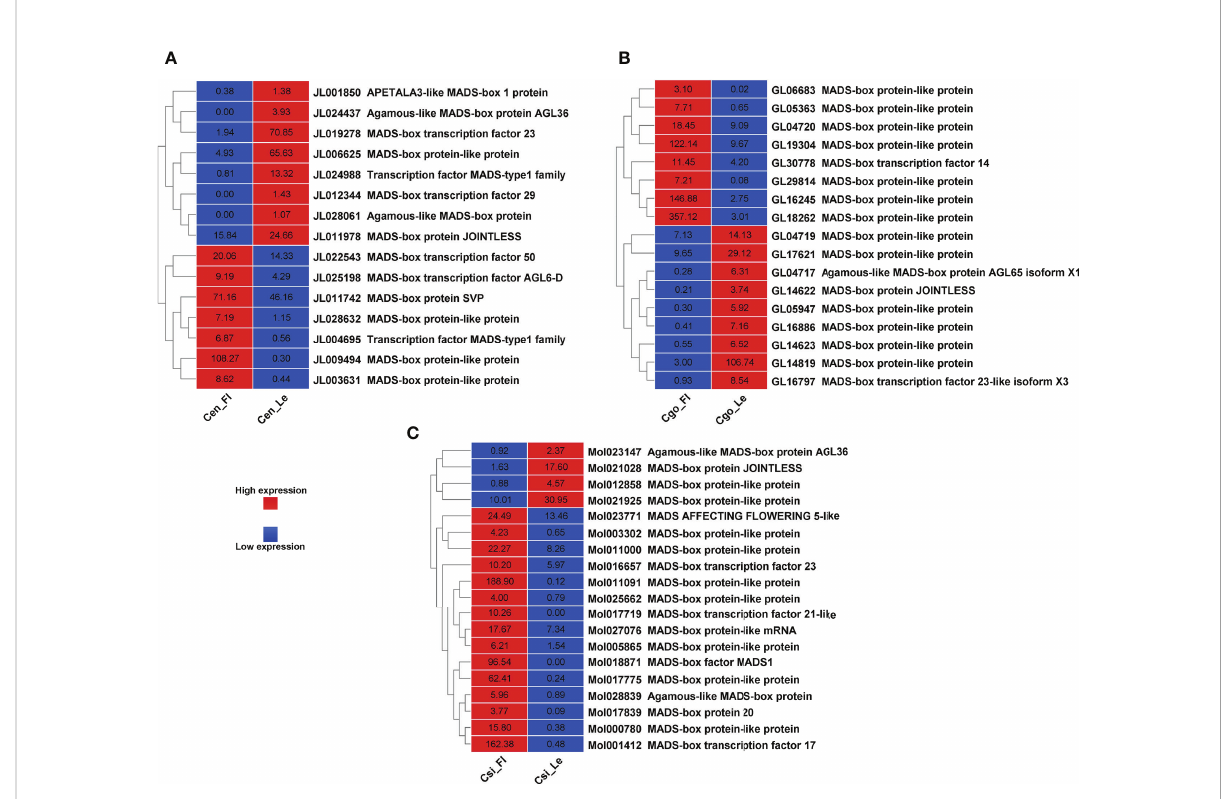
FIGURE 6 MADS-box genes for C. ensifolium (A) , C. goeringii (B) and C. sinense (C)